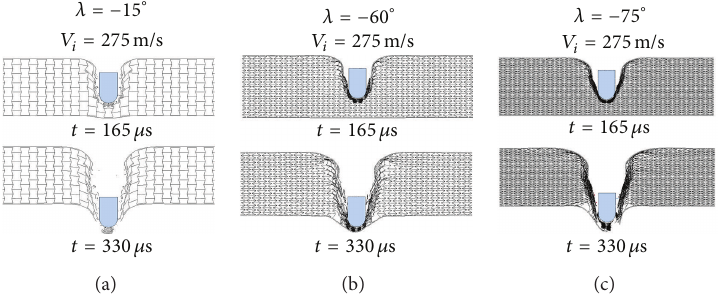
Figure 19: Snapshots of impact processes of auxetic HPSs with different reentrant unit cell angles by projectiles at 𝑉 𝑖 = 275 m/s: (a) 𝜆 = −15 ∘ , (b) 𝜆 = −60 ∘ , and (c) 𝜆 = −75 ∘